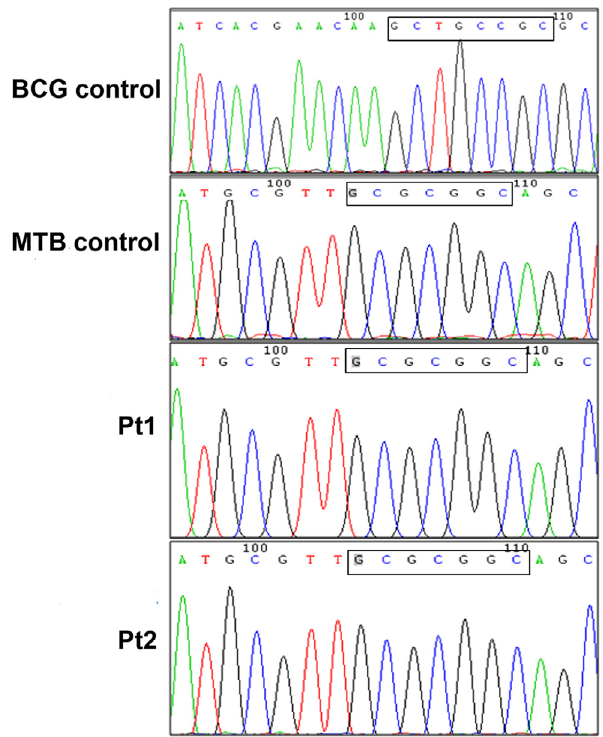
Figure 5. Chromatograms of nucleotide sequences of the two positive samples compared with Mycobacterium tuberculosis and Bacillus Calmette-Guerin control samples showing sequences identical with Mycobacterium tuberculosis . MTB, Mycobacterium tuberculosis ; BCG, Bacillus Calmette-Guerin; Pt1, sample from patient 1; Pt2, sample from patient